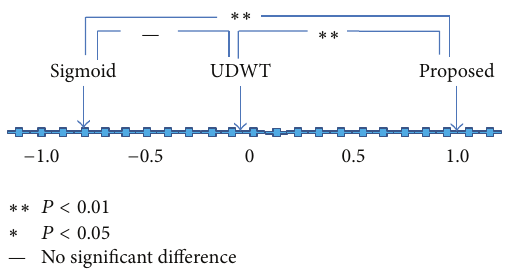
Figure 7: Preference ranking map for the three image groups: STWC-mapping-method-processed, modified-UDWT-processed, and proposed-method-processed mammograms.